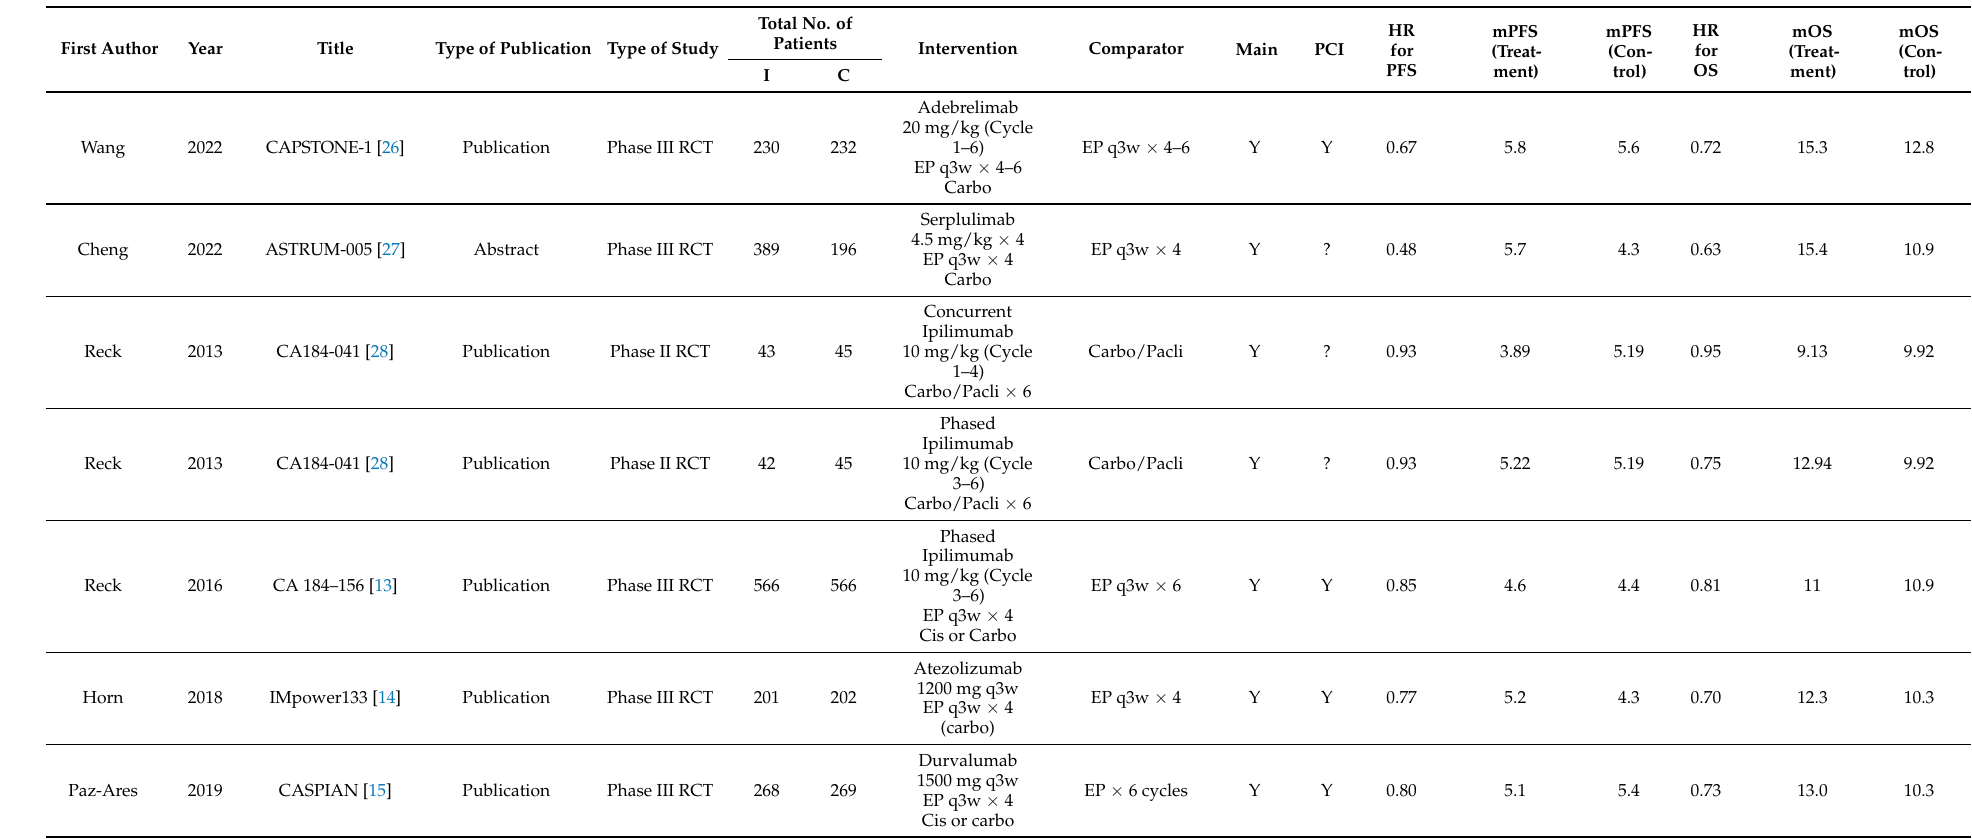
Table 1. Table of included studies and characteristics. I, intervention; C, comparator; PCI, prophylactic cranial irradiation; HR, hazard ratio; mPFS,